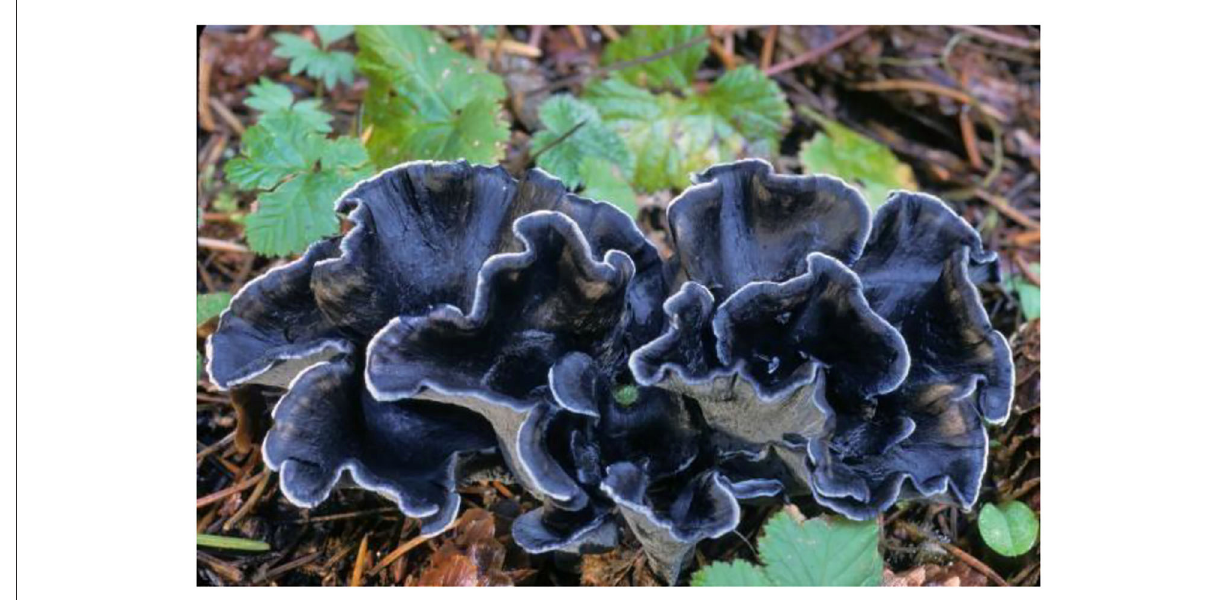
FIGURE8 Blue chanterelle mushroom Polyozellus multiplex from the family Thelephoraceae